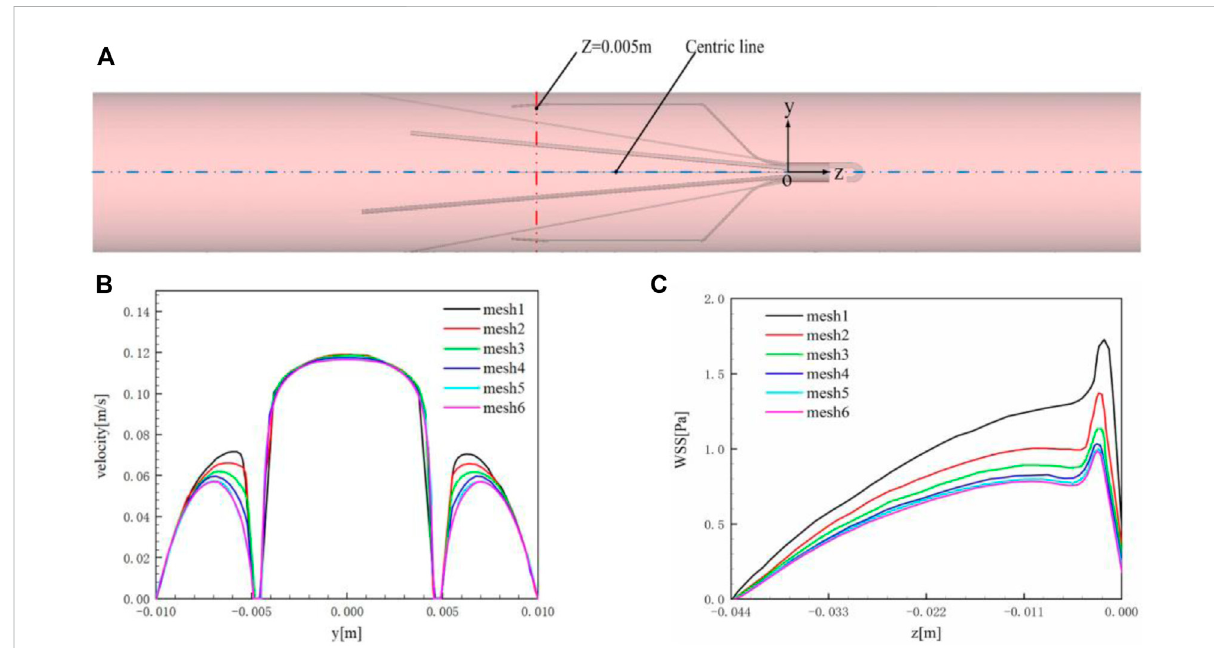
FIGURE 4 (A) z = 0.005 m cross-section and centric line ( x = 0 m, y = 0 m); (B) velocity pro fi le in the y -axis direction at z = 0.005 m cross-section; (C) WSS avg of the fi lter surface.